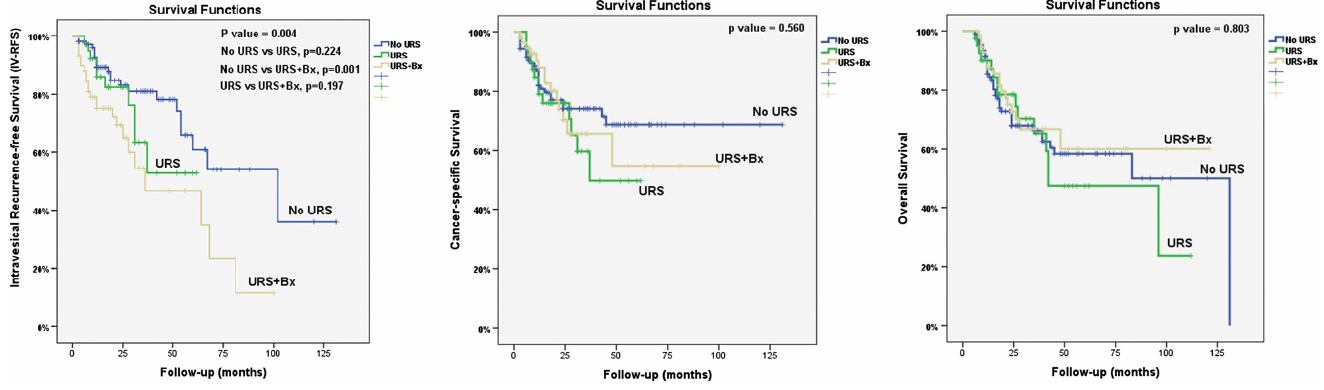
Figure 2. Kaplan–Meier curves for intravesical recurrence-free survival, cancer-specific survival, and overall survival according to groups. URS: ureterorenoscopy, bx: biopsy .